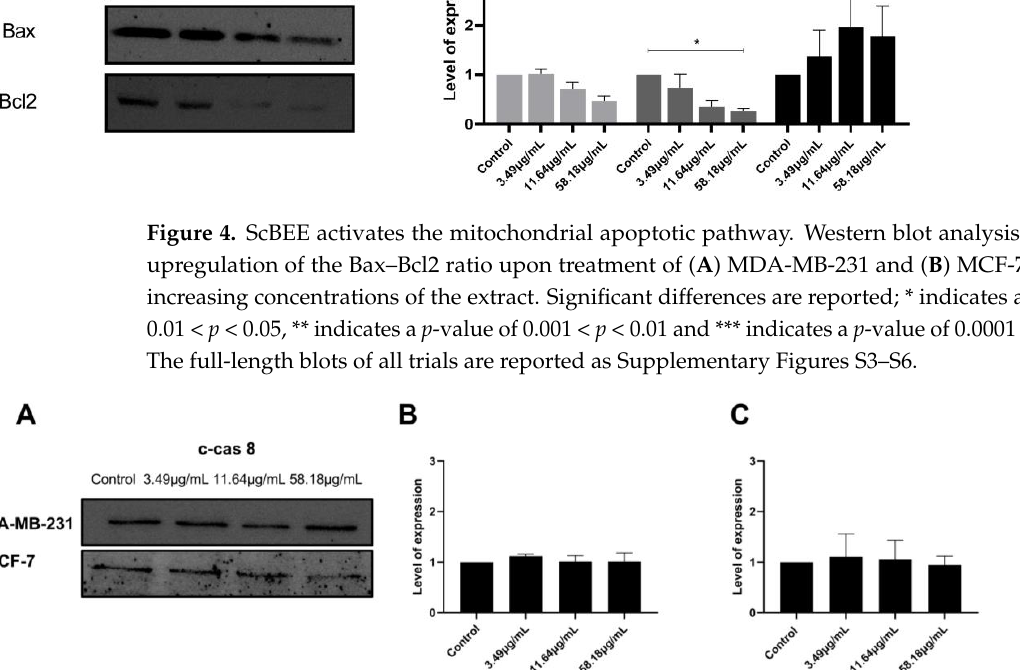
Figure 6. Antioxidant properties of ScBEE in breast cancer cell lines. Measurement of reactive oxy- gen species production in ( A ) MDA-MB-231 and ( B ) MCF-7 cells showed a significant decrease, resulting in increased concentrations of ScBEE. TBHP and NAC were used as positive and negative controls, respectively. Significant differences are reported; * indicates a p-value of 0.01< p < 0.05, ** indicates a p-value of 0.001 < p < 0.01 and *** indicates a p-value of 0.0001< p < 0.001.